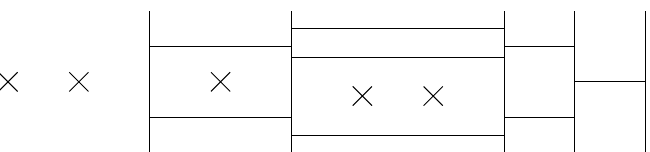
Figure 1. Generic brane con(cid:12)guration. The horizontal direction corresponds to spatial direction x 6 . Horizontal lines are D3-branes. The vertical direction corresponds to spatial directions ~x = ( x 3 ; x 4 ; x 5 ). Vertical lines are NS5-branes. The direction perpendicular to the paper corresponds to spatial directions ~y = ( x 7 ; x 8 ; x 9 ). Crosses are